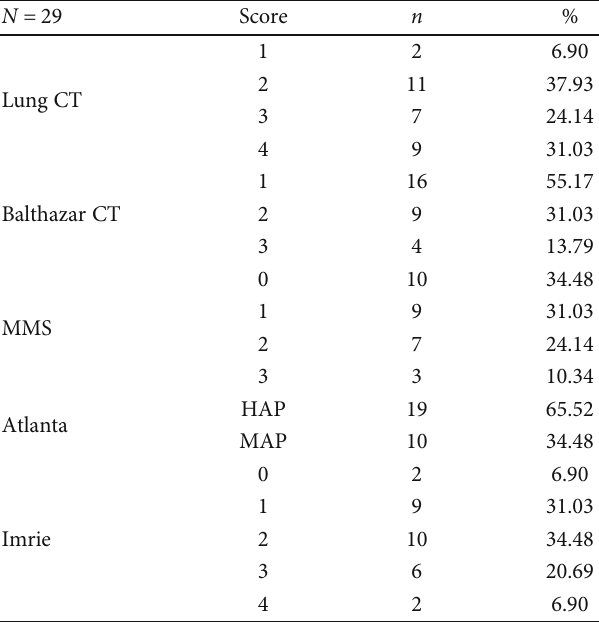
Table 1: Laboratory fi ndings of patients with COVID-19 and acute pancreatitis.